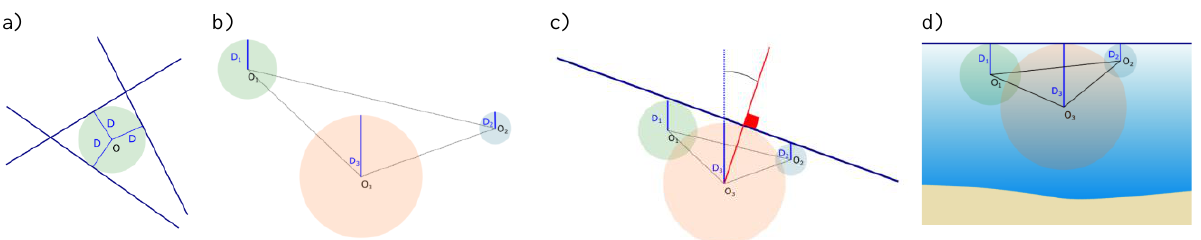
Figure 3 . Geometric principles of scaling and levelling with depth measurements. a) A depth measurement identifies a circle of position, centered in the camera and with radius equal to the measured depth value. The water level can be tangent at any point of the circle. b) Three different depth measurements define three circles of position. c) For the water line being tangent to the three circles, the triangle defined by the three tangential points is isotropically scaled. d) A rotation is applied to make the water line